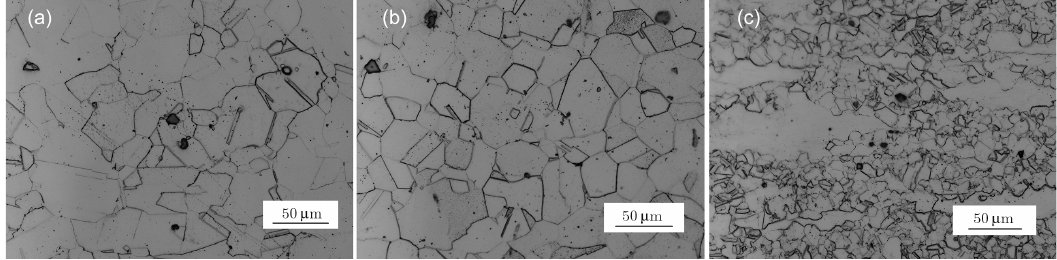
Figure 5: Microstructures of samples deformed at 1,100°C at different strain rates: (a) 0.01 s – 1 ; (b) 0.1 s – 1 ; and (c) 1 s – 1